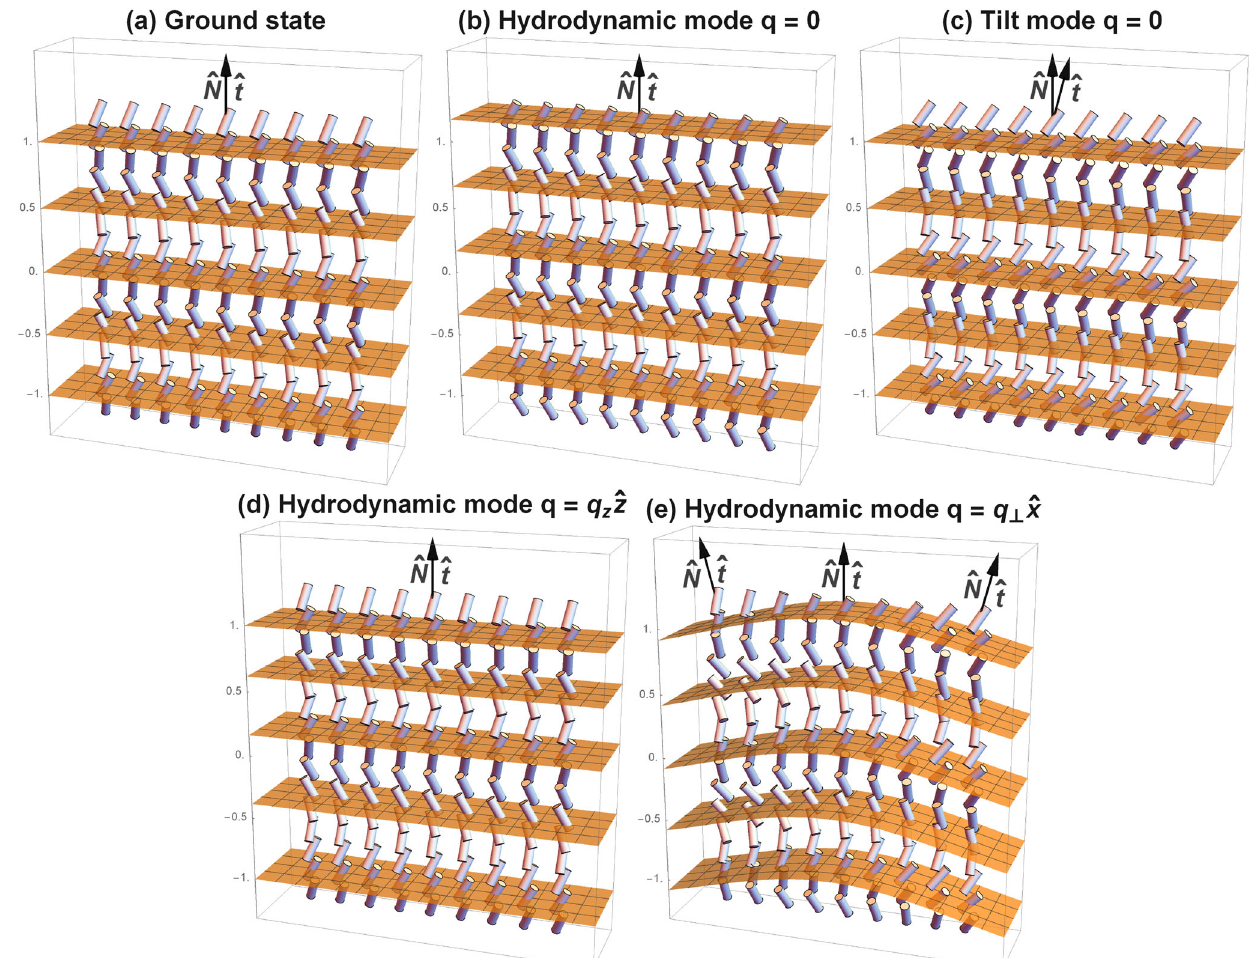
FIG. 8. Visualization of certain fluctuation modes in the N phase [29]. Small cylinders represent the heliconical director field ˆ n ð r Þ , TB and surfaces represent the pseudolayers. (a) Ground state. (b) Hydrodynamic mode with wave vector q ¼ 0 , with uniform rotation of ˆ n ð r Þ and hence uniform displacement of pseudolayers; this mode has no energy cost with respect to the ground state. (c) Non- hydrodynamic tilt mode, with the coarse-grained director ˆ t [average of ˆ n ð r Þ ] tilted with respect to pseudolayer normal. (d) Hydro- dynamic mode with q ¼ q ˆ z , with z -dependent rotation of ˆ n ð r Þ and z -dependent displacement of pseudolayers (leading to compression and dilation). (e) Hydrodynamic mode with q ¼ q ˆ x , with x -dependent rotation of ˆ n ð r Þ and x -dependent displacement of pseudo-layers (leading to curvature), accompanied by tilt so that ˆ t remains normal to